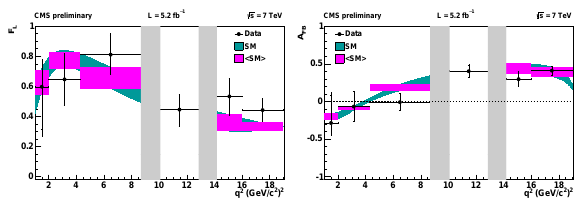
Figure 4. Results of the measurements of F L (left) and A FB (right) in q 2 bins. The statistical (total) errors on the data points are represented by the shorter (longer) error bars. The gray re- gions correspond to the J /ψ and ψ (cid:48) bins. The SM prediction is given by the cyan band. The average SM prediction for each q 2 bin is shown by the magenta boxes.